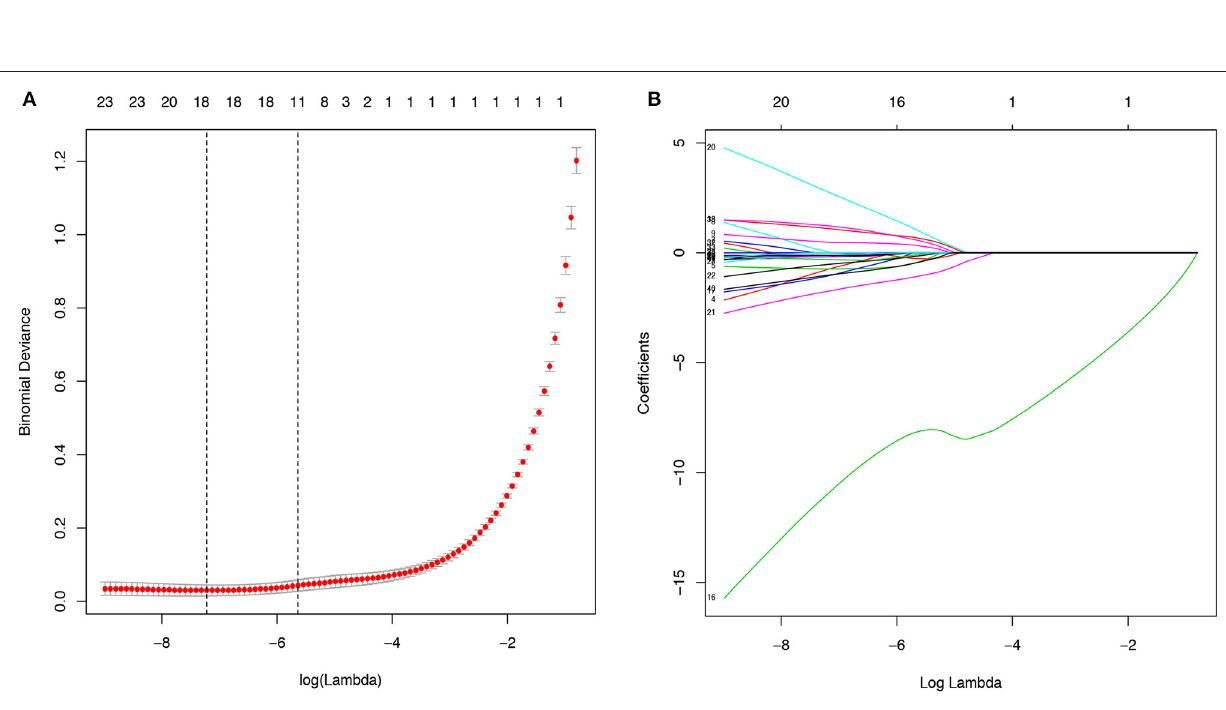
Frontiers in Medicine |